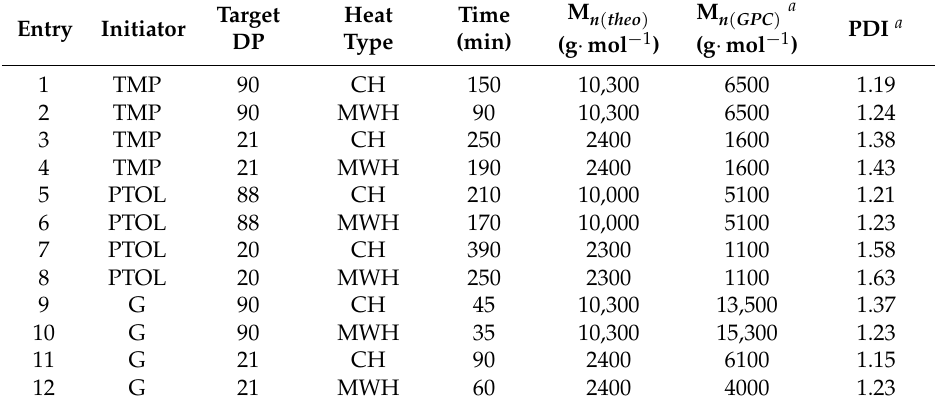
Table 1. Results of CH & MWH ROP to Synthesise Hydrophobic Homopolymer Initiated by TMP, PTOL & Glycerol (G) with CL/Sn(Oct) 2 ratio of 1:2.80 ˆ 10 ´ 4 at 150 ˝ C.